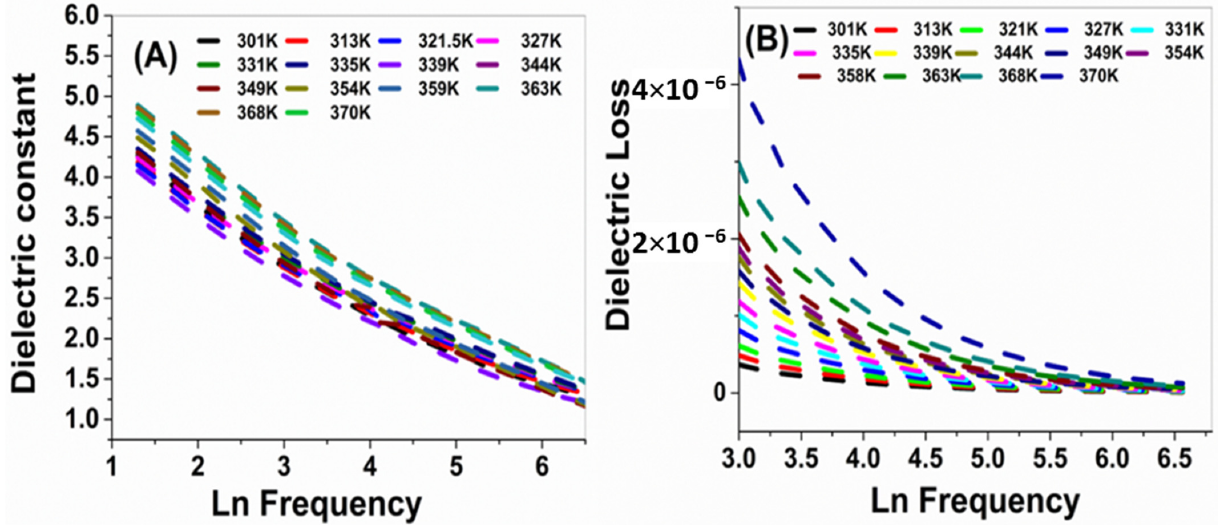
Figure 7. Dielectric analysis of nanocomposite; ( A ) dielectric constant and ( B ) dielectric loss as a function of frequency.